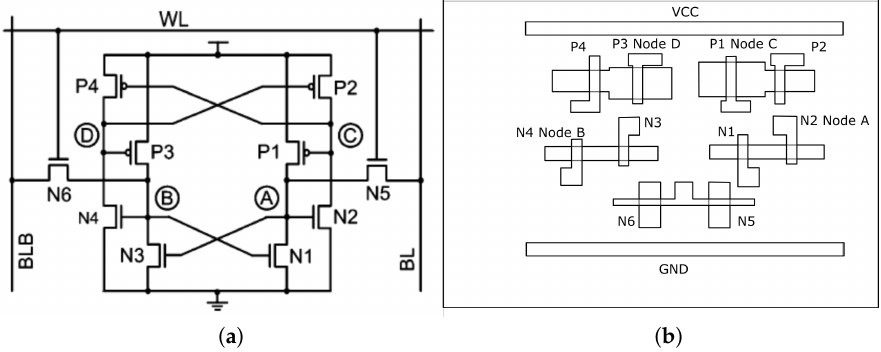
Figure 8. ( a ) Diagram of Quatro design [29]; ( b ) Layout of Quatro